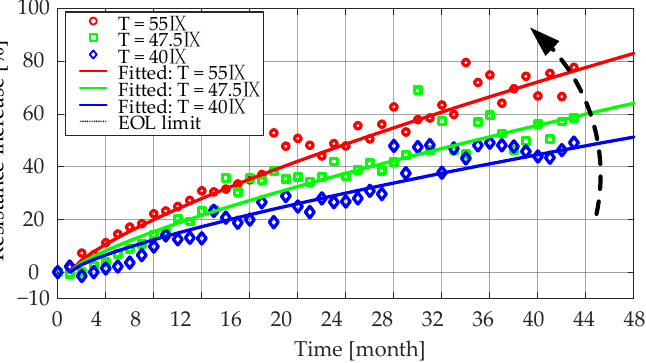
Figure 15. Effects of storage time and temperature on the increase of the resistance (at 50% SOC level). Table 5. The curve fitting coefficients of the resistance increase model considering temperature variation (SOC level is fixed to 50%).